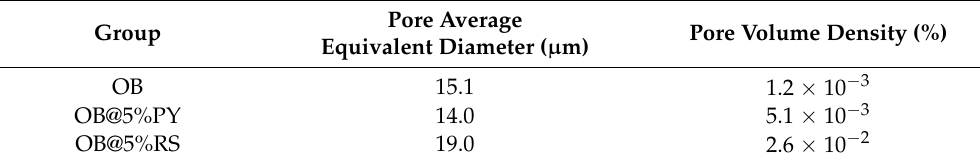
Table 4. Pore characteristics of OB, OB@5%RS and OB@5%PY as calculated from µ CT